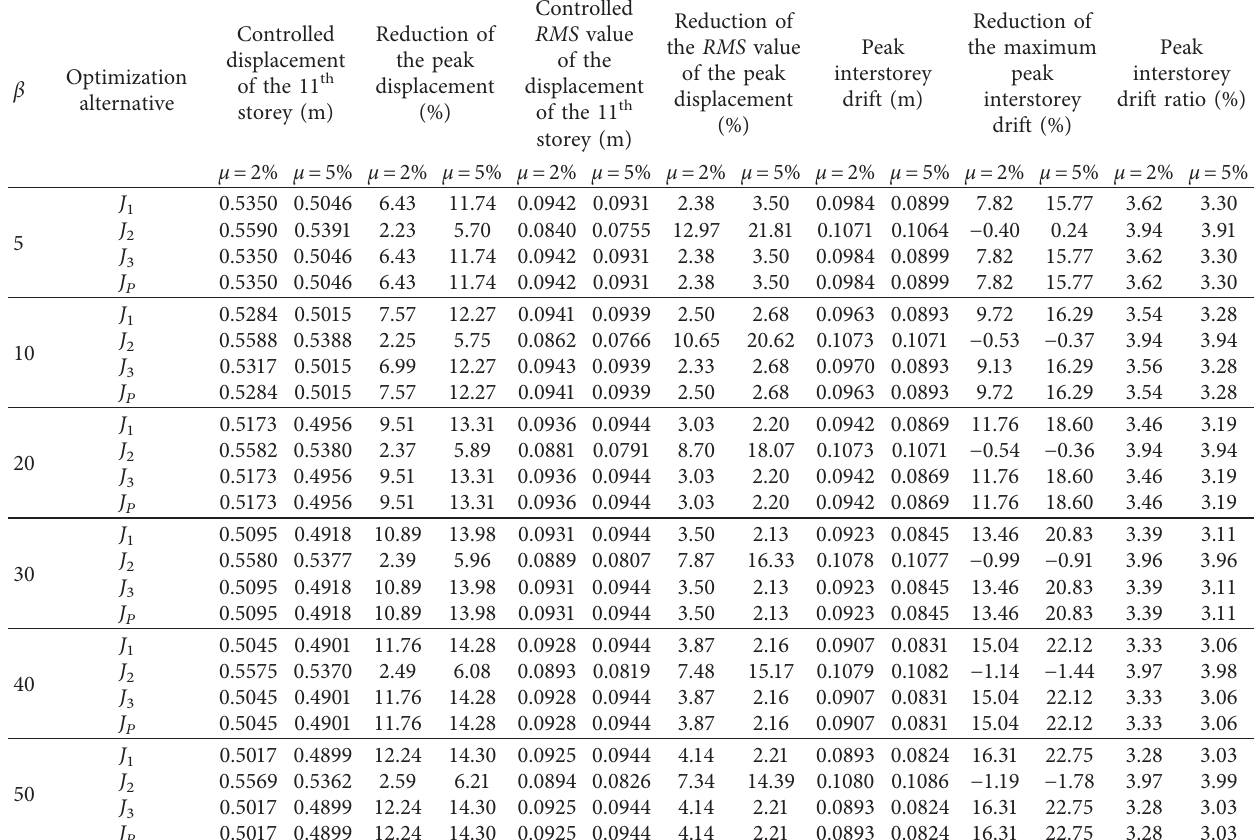
Table 13: Controlled response of the structure subjected to “ Kobe ”